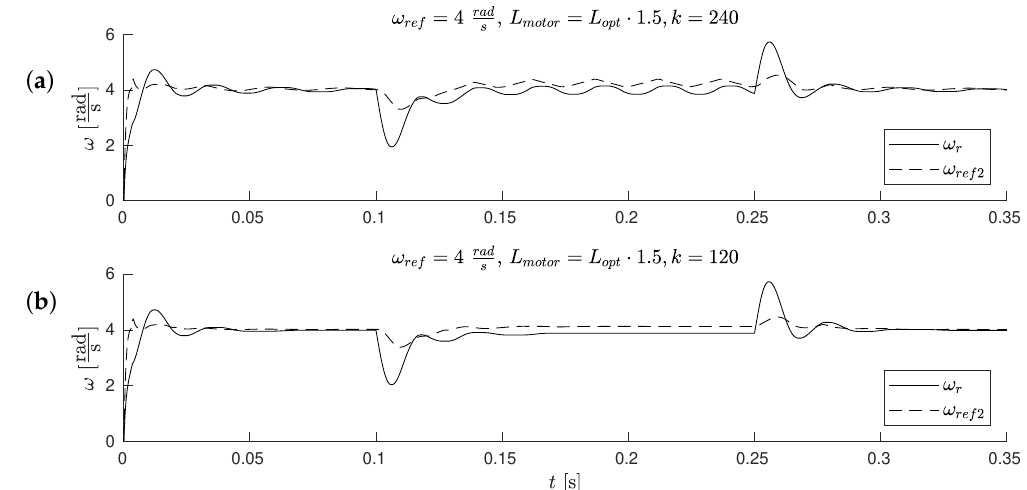
Figure 14. Waveforms measured ω r and corrected reference ω ref 2 speed waveforms, for the wrong estimation of motor inductance and for different values of gain k (amplification of correction angle input); the initial position equals 0 ◦ . ( a ) L motor = L opt